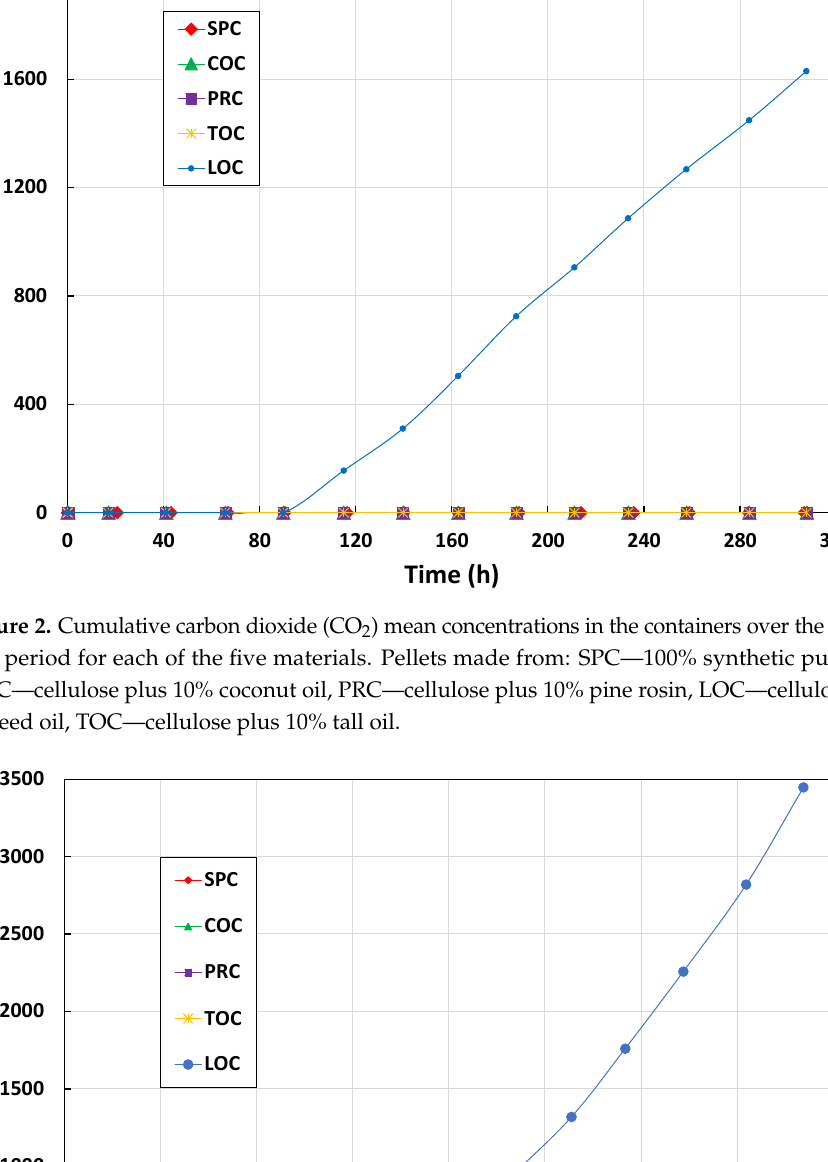
Figure 1. Cumulative carbon monoxide (CO) mean concentrations in the containers over the thirteen days test period for each of the five materials. Pellets made from: SPC—100% synthetic pure cellulose, COC—cellulose plus 10% coconut oil, PRC—cellulose plus 10% pine rosin, LOC—cellulose plus 10% linseed oil, TOC—cellulose plus 10% tall oil.